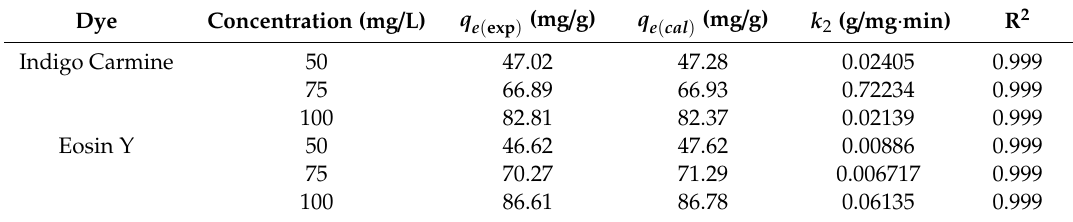
Table 2. Summary of the second order rate constant values.